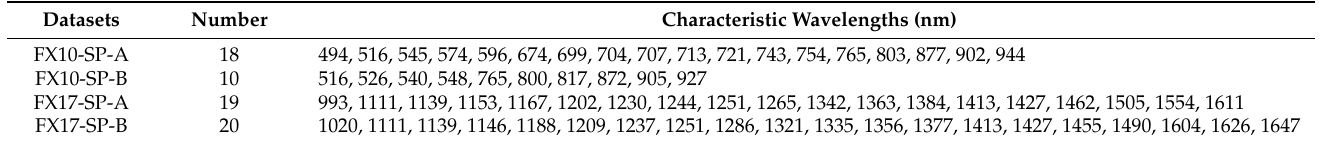
Table 3. Characteristic wavelengths selected by SPA for the datasets of the two sides of the two hyperspectral image